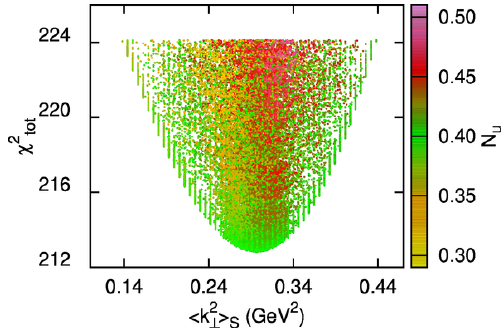
Figure 3 . Allowed values for the width of the Sivers function h k 2 region displayed corresponds to our estimate of 2 (cid:27) C.L. error